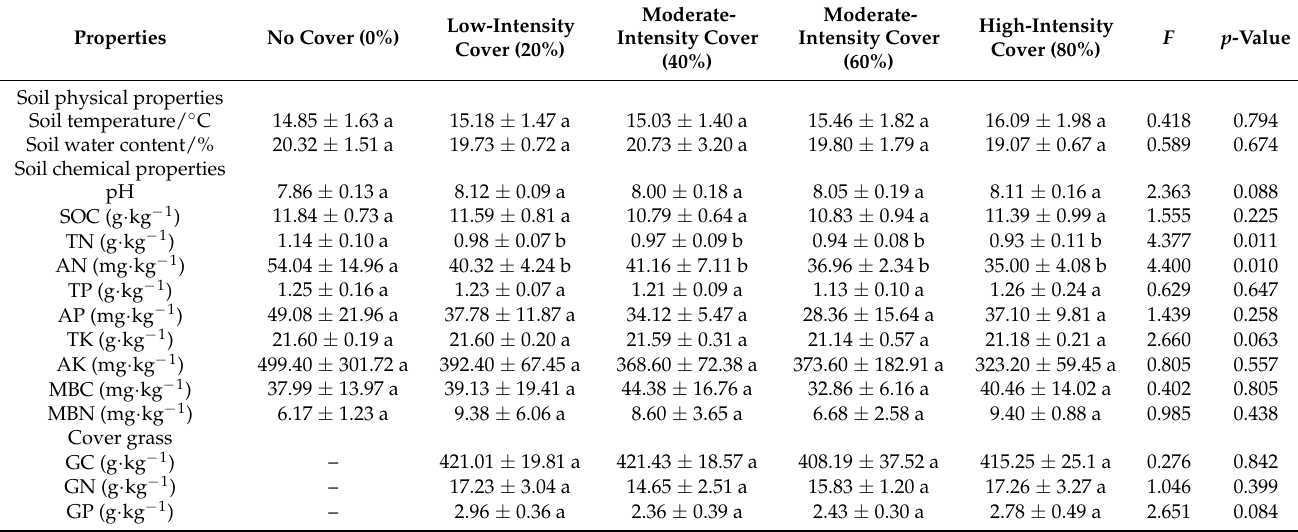
Table 1. Soil and cover grass properties for different